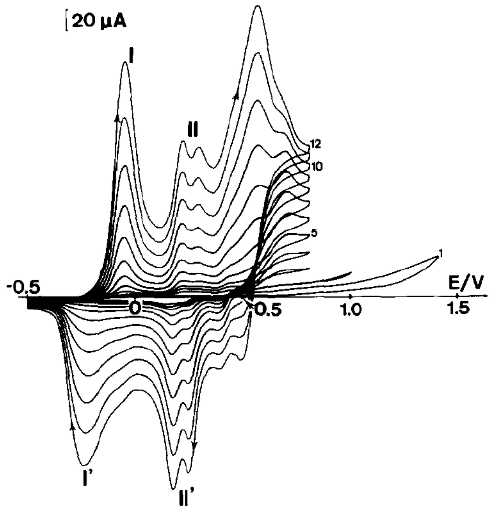
Figure 1. Growth of polyaniline film from a 0.1 M aniline solution in 1 M sulfuric acid achieved via cyclic voltammetry. Sweep rate was 50 mV/s; electrode area was 1 cm 2 . Reprinted from [13], Copyright 1990, with permission from Elsevier.